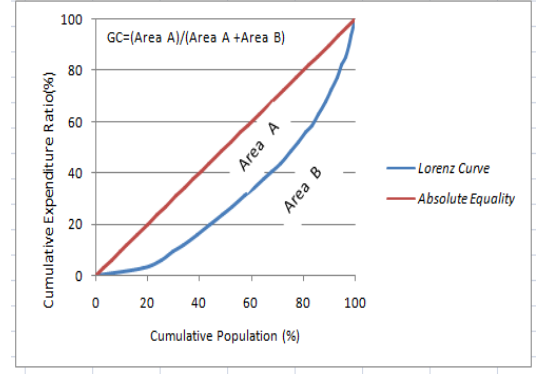
Figure 1. Lorenz Curve and Gini Coefficient